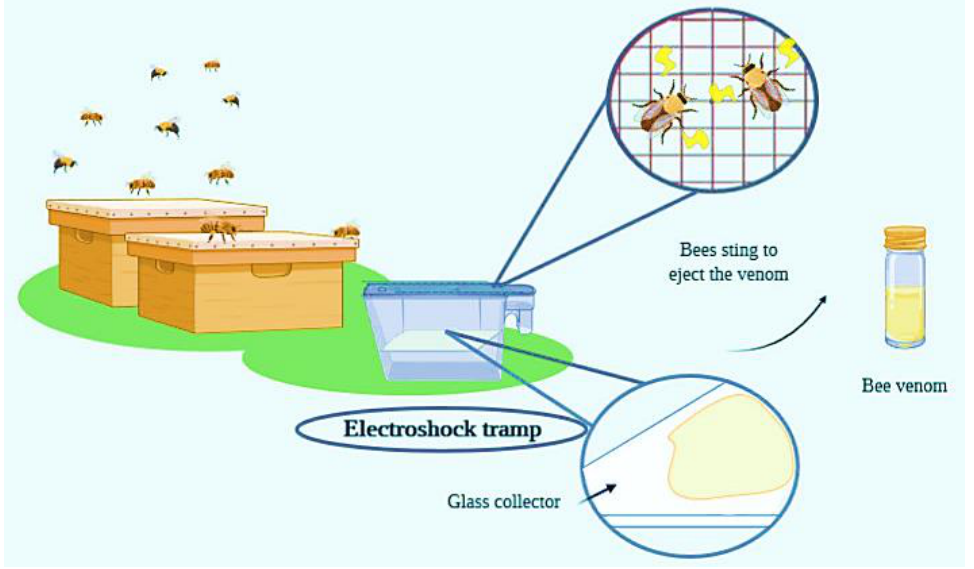
Figure 1. Scheme and process flow of typical bee venom collection by means of using an electroshock trap. Bees are submitted to an electric current, and consequently they eject the venom, which is collected on a glass plate and then transferred to bottles for further processing.